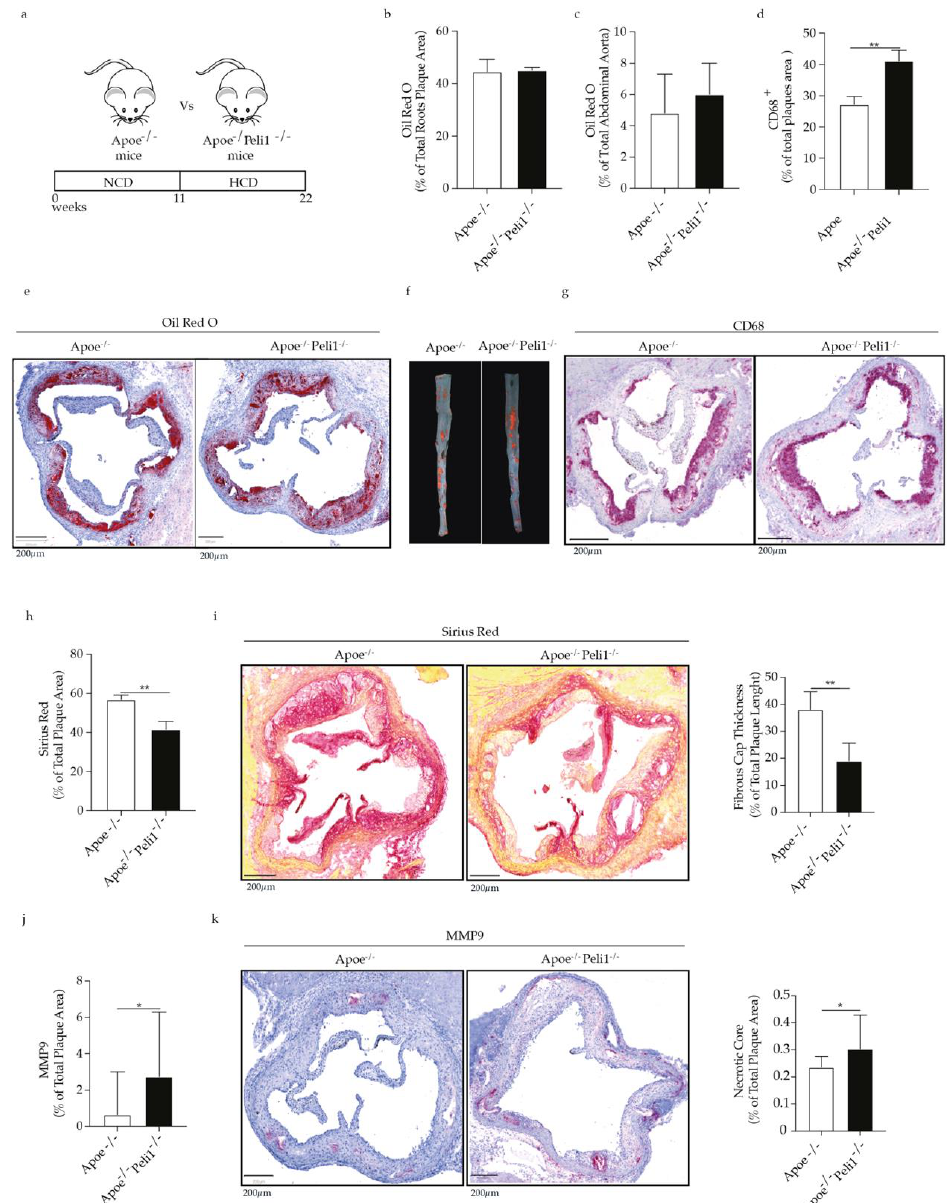
Figure 1. ( a ) Scheme illustrating the animal experimental settings. Bar graphs represent lipids accumulation as quantified by Oil Red O staining ( b ) in the aortic roots ( c ) in the abdominal aorta of Apoe − / − and Apoe − / − Peli1 − / − mice. ( d ) Bar graphs represent quantification of total CD68 macrophages present in the aortic roots of Apoe − / − and Apoe − / − Peli1 − / − mice on HCD. Representative images of ( e ) Oil Red O staining in the aortic roots, ( f ) Oil Red O staining in the abdominal aorta and ( g ) CD68 immunohistochemistry staining in the aortic roots of Apoe − / − and Apoe − / − Peli1 − / − mice. ( h ) Bar graphs and representative images showing quantification of collagen accumulation in the aortic roots of Apoe − / − and Apoe − / − Peli1 − / − mice fed HCD. ( i ) Bar graphs represent the quantification of the fibrous cap thickness in Apoe − / − and Apoe − / − Peli1 / − mice fed HCD. ( j ) Bar graphs and representative images showing the quantification of MMP9 expression in the aortic roots of Apoe − / − and Apoe − / − Peli1 − / − mice fed HCD. ( k ) Bar graphs represent the quantification of necrotic core area in the aortic roots of Apoe − / − and Apoe − / − Peli1 − / − mice, fed HCD, n = 7–8/group, U-Mann Whiney, all data are presented as median with interquartile range with p ≤ 0.05 * and p ≤ 0.01